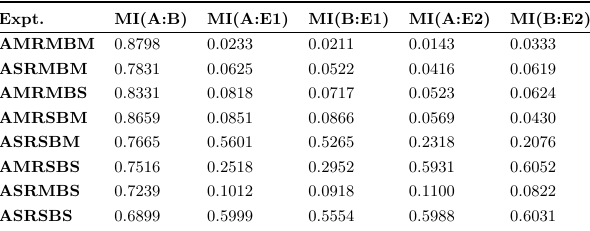
Table 2: Mutual information (in bits) for various experimental scenarios. Expt.